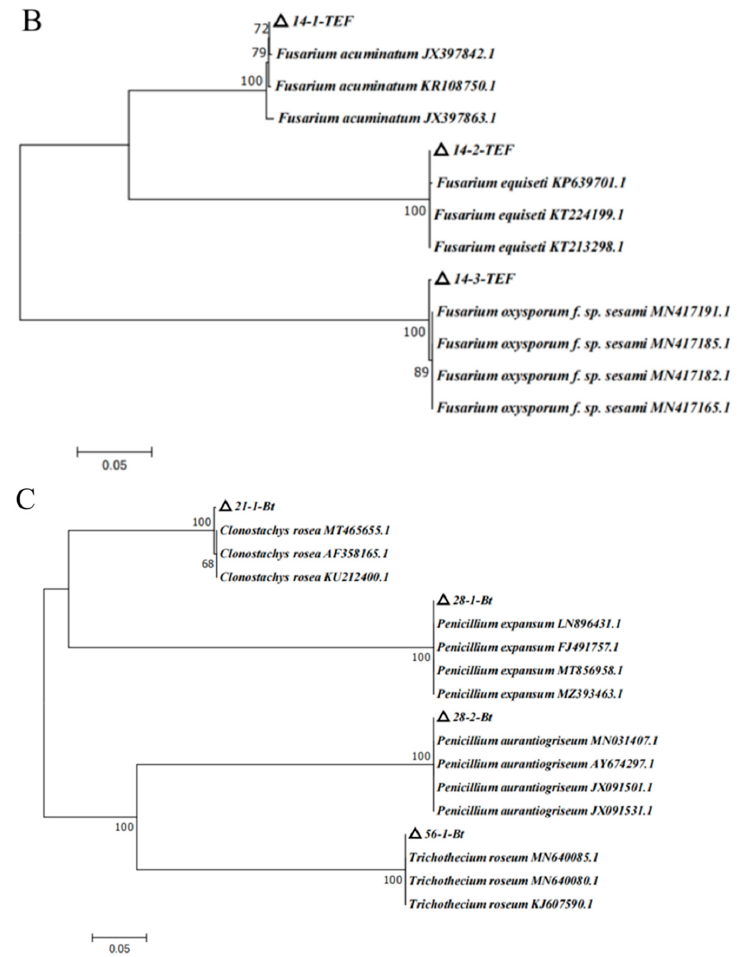
Figure 6. Phylogenetic tree of isolates based on analysis of different fungal genes. ( A ) ITS phylogenetic tree; ( B ) TEF phylogenetic tree; ( C ) TUB phylogenetic tree.